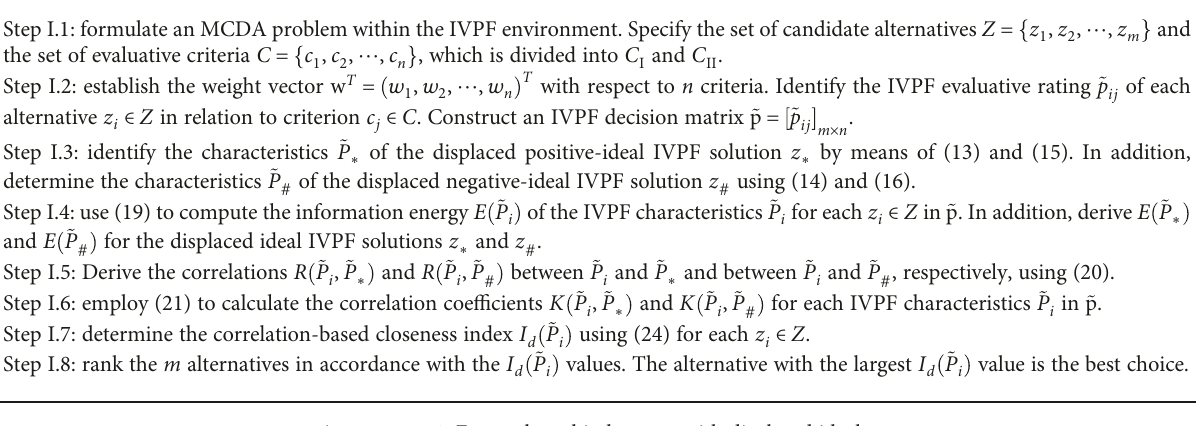
Algorithm 1: For anchored judgments with displaced ideals.